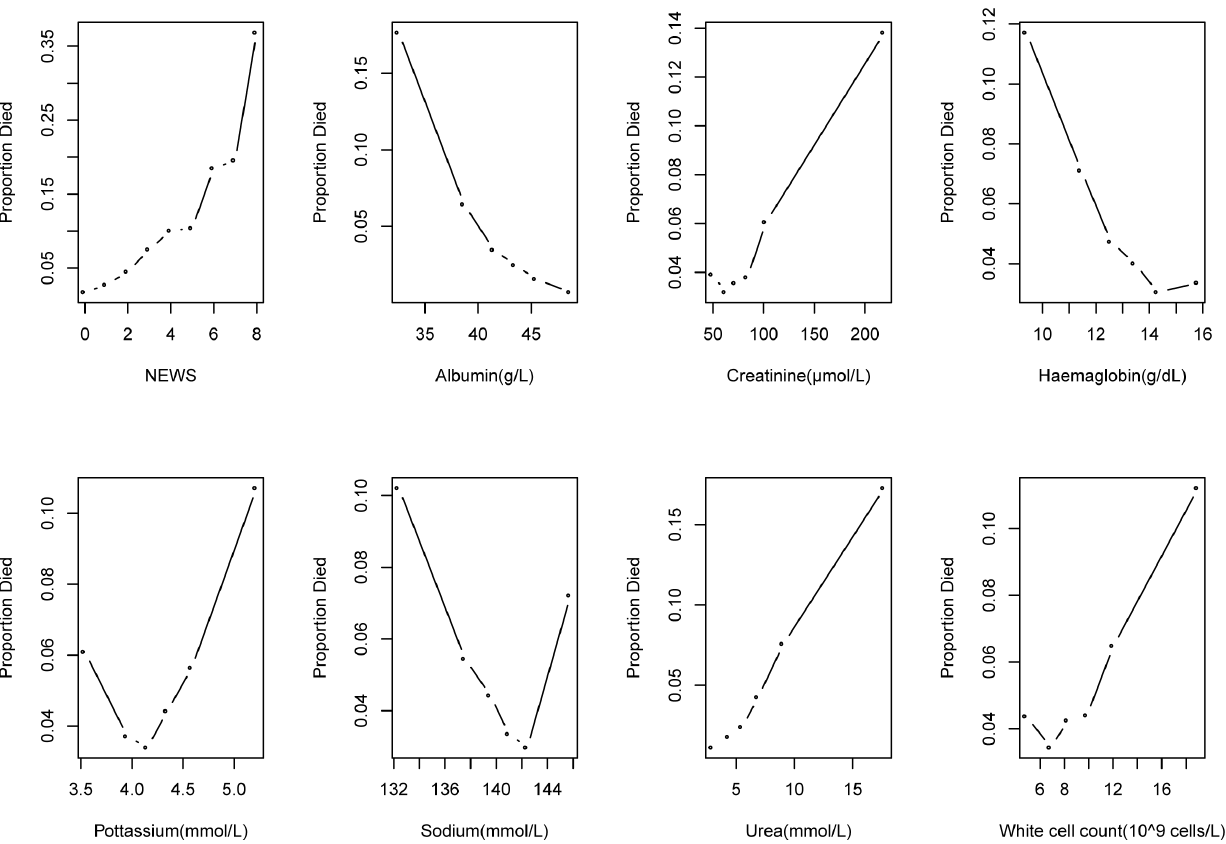
Figure 1. Scatter plots showing observed risk of death with NEWS and seven blood tests results.